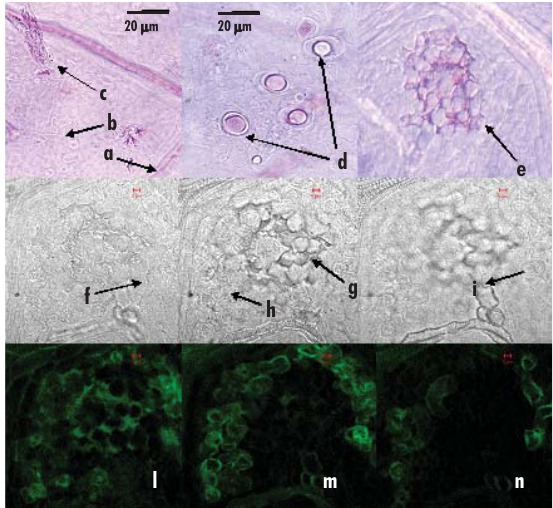
Fig. 2. Acremonium byssoides growth in leaf tissues in- oculated with Plasmopara viticola (late January). (a–e) Differential interferential contrast light microscopy im- ages. (a) Hyphae of A. byssoides growing out of the veins (2 dpi), passing between parenchyma cells, (b) reaching the hyaline oomycete mycelium, partly invading it, and (c) anomalous sporangiophores within red-stained granular masses emerging from the stomata. (d) Mycelium and sexual structures (gametangia and oospores) of P. viticola , invaded and deformed by A. byssoides . (e) Phialides and conidia of A. byssoides emerging from the stomata and the intercellular spaces of the abaxial epidermis. The associ- ated deformed host cells are also stained red. (f–n) A series of confocal images through the focal planes of discoloured and aniline-stained P. viticola -infected fragments using transmitted and fl uorescent light. (f) Deformed host cells with endophyte tracks. (g) Host cells surrounded by A. byssoides hyphae. (h) A. byssoides phialides with conidia inside and/or outside the host cells. (i) A. byssoides hyphae passing from the secondary veins into the host cells. (l–n) Hyphae of P. viticola between host cells, extending into the mesophylls.